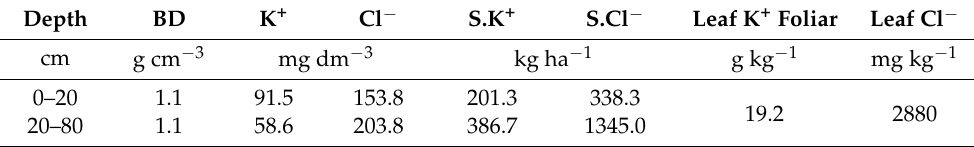
Table 1. Initial content and stocks of K and Cl in the soil and in the leaves of coffee plants.